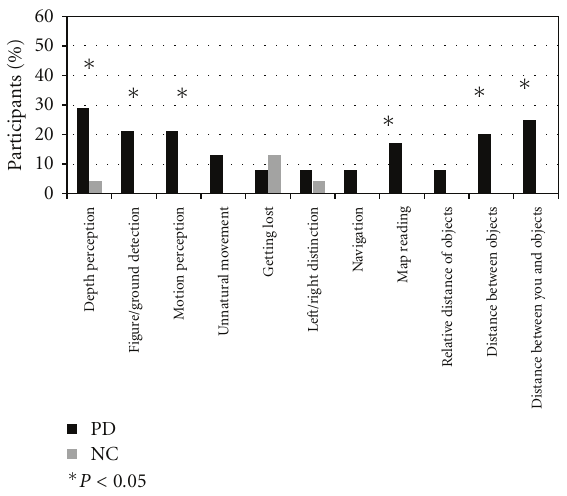
Figure 1: Percentage of PD and HC participants reporting im- pairment on the visual and visuospatial items from the web-based questionnaire.